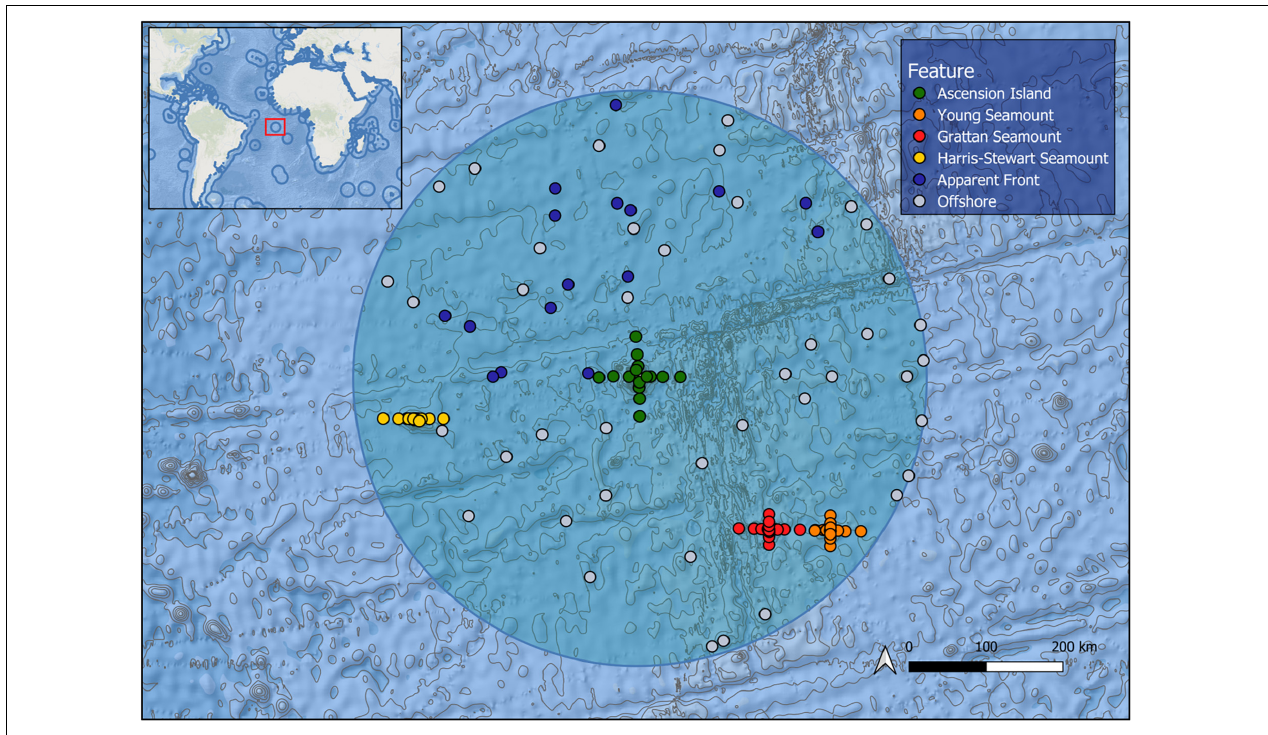
FIGURE 1 | Map of the Ascension Island EEZ (shaded circle) showing bathymetry and sampling effort by feature, each point represents a deployment of five mid-water